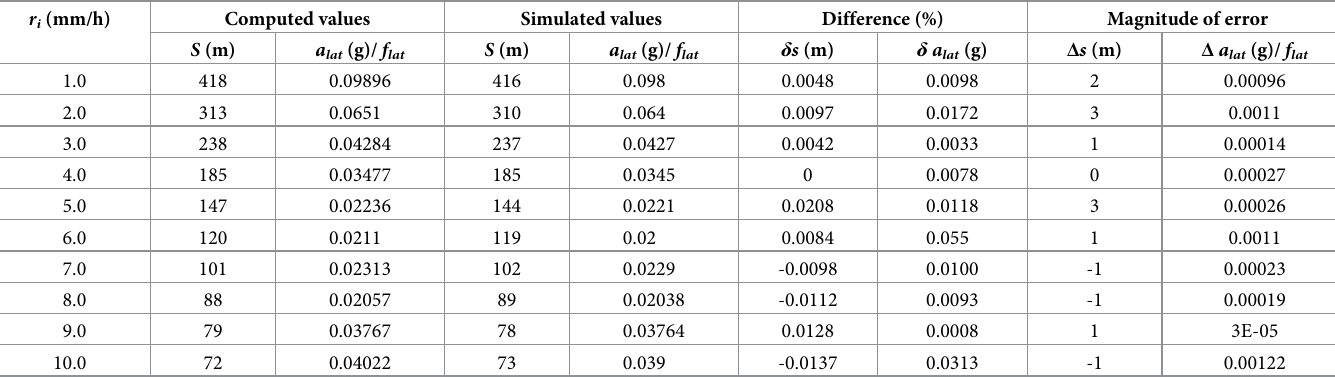
Table 4. Comparison of the computed and simulated